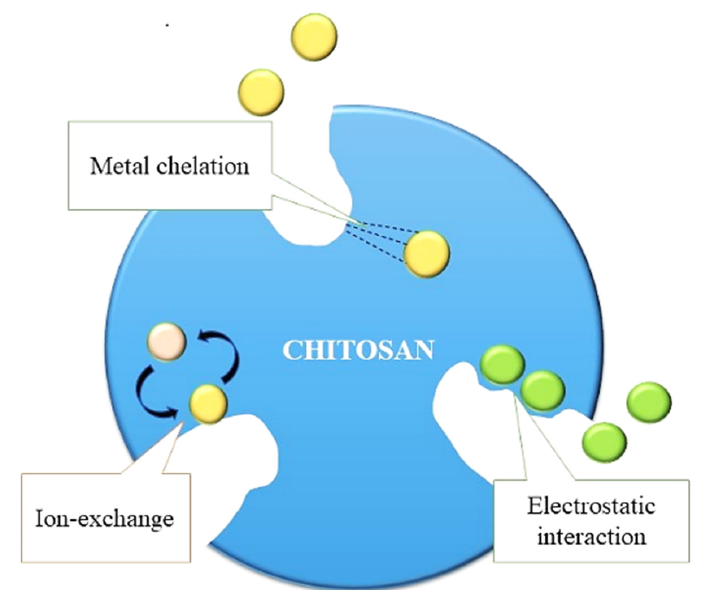
Figure 3. Various adsorption mechanisms of